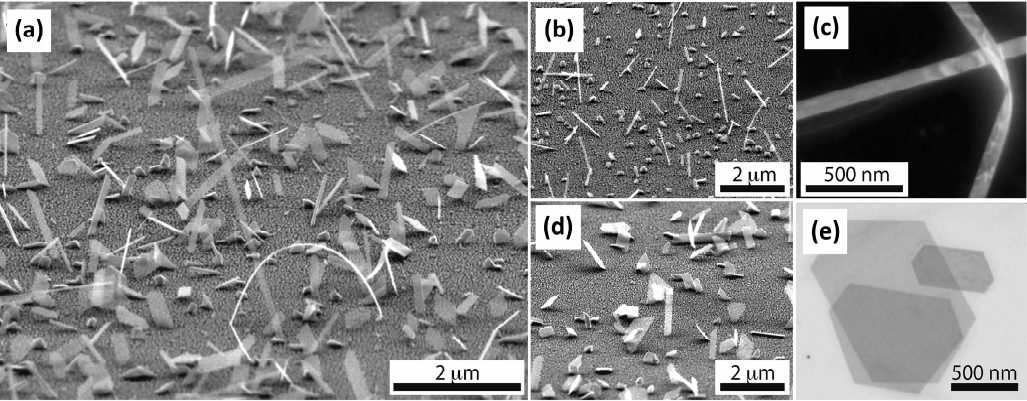
Figure 5. Bi 2 Se 3 nanoribbons and platelets: ( a , b , d ) SEM images of as-grown samples and ( c , e ) images obtained after deposition on TEM grids [78].